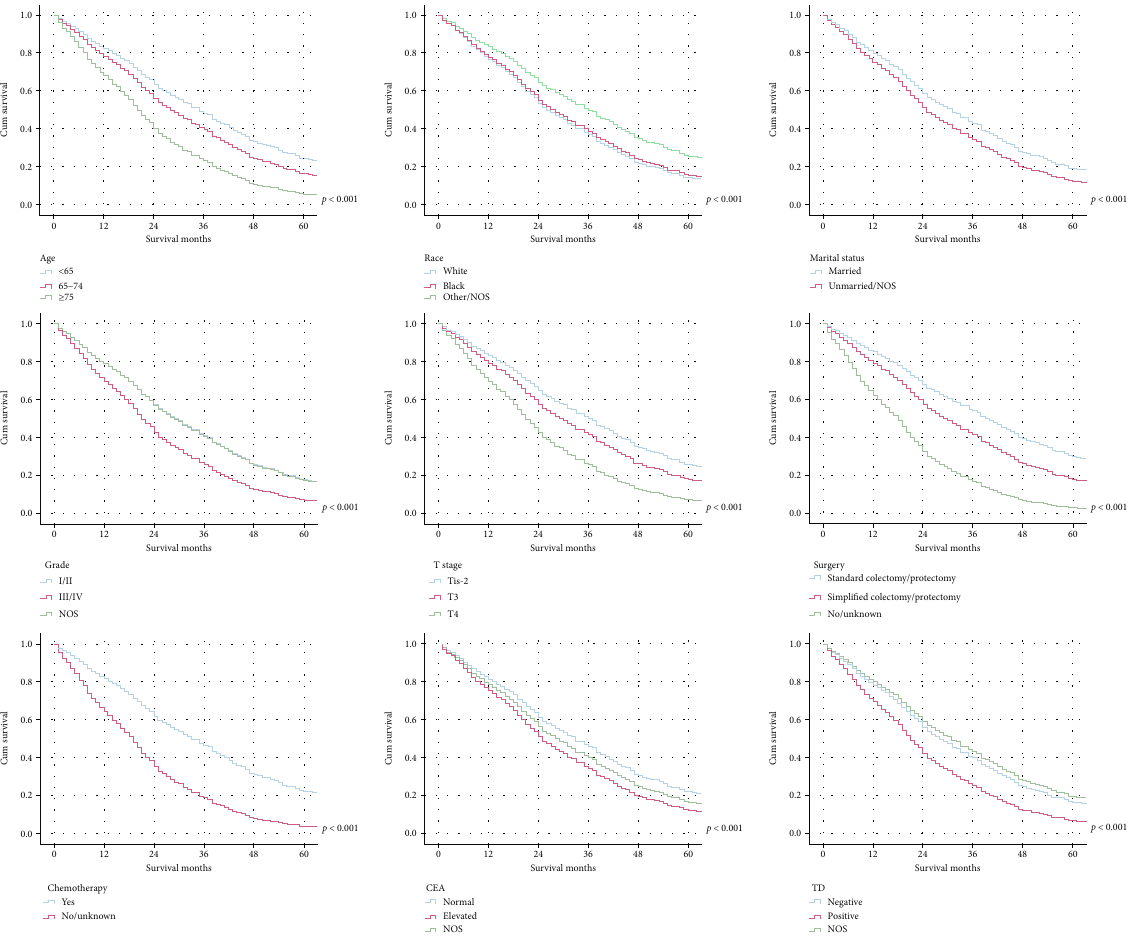
Figure 3: The cumulative survival curves revealed the in fl uence of each prognostic factor on survival after controlling the other